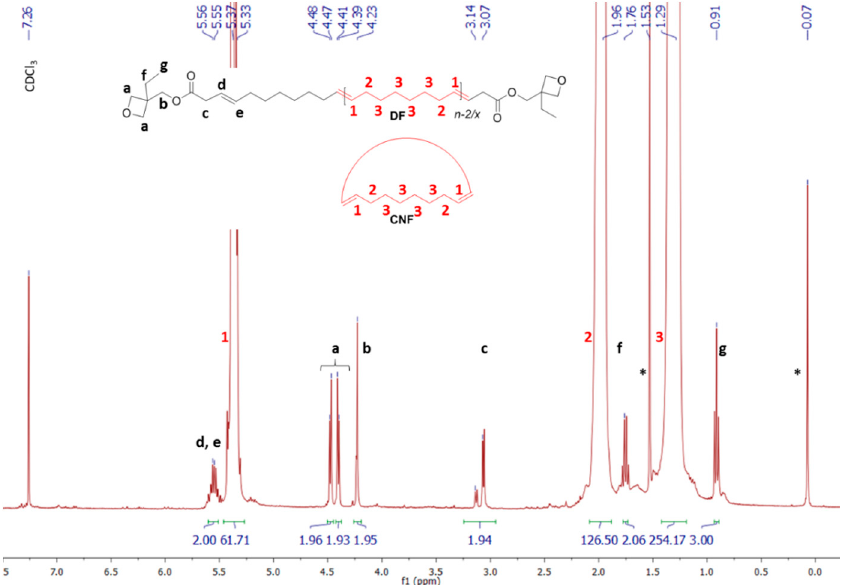
Figure 1. 1 H NMR spectrum (500 MHz, CDCl 3 , 25 °C) of an α , ω -dioxetane telechelic PCOE sample